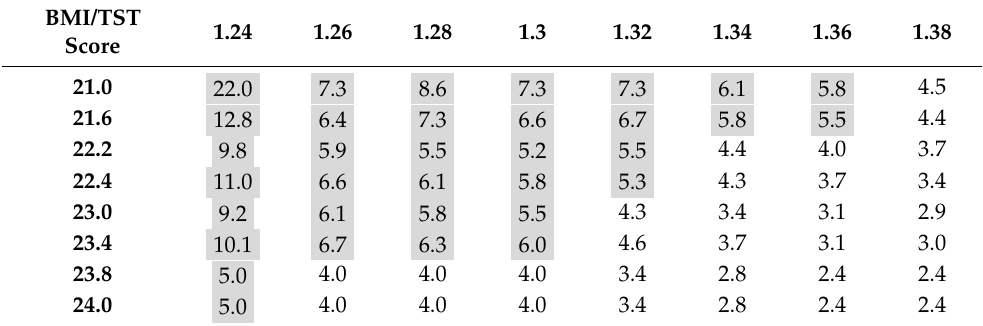
Figure 2. Receiver operating characteristic curve for detecting osteoporosis with the combination of body mass index and two-step test. Table 6. Calculations of positive likelihood ratios for combinations of body mass index and two- step test.